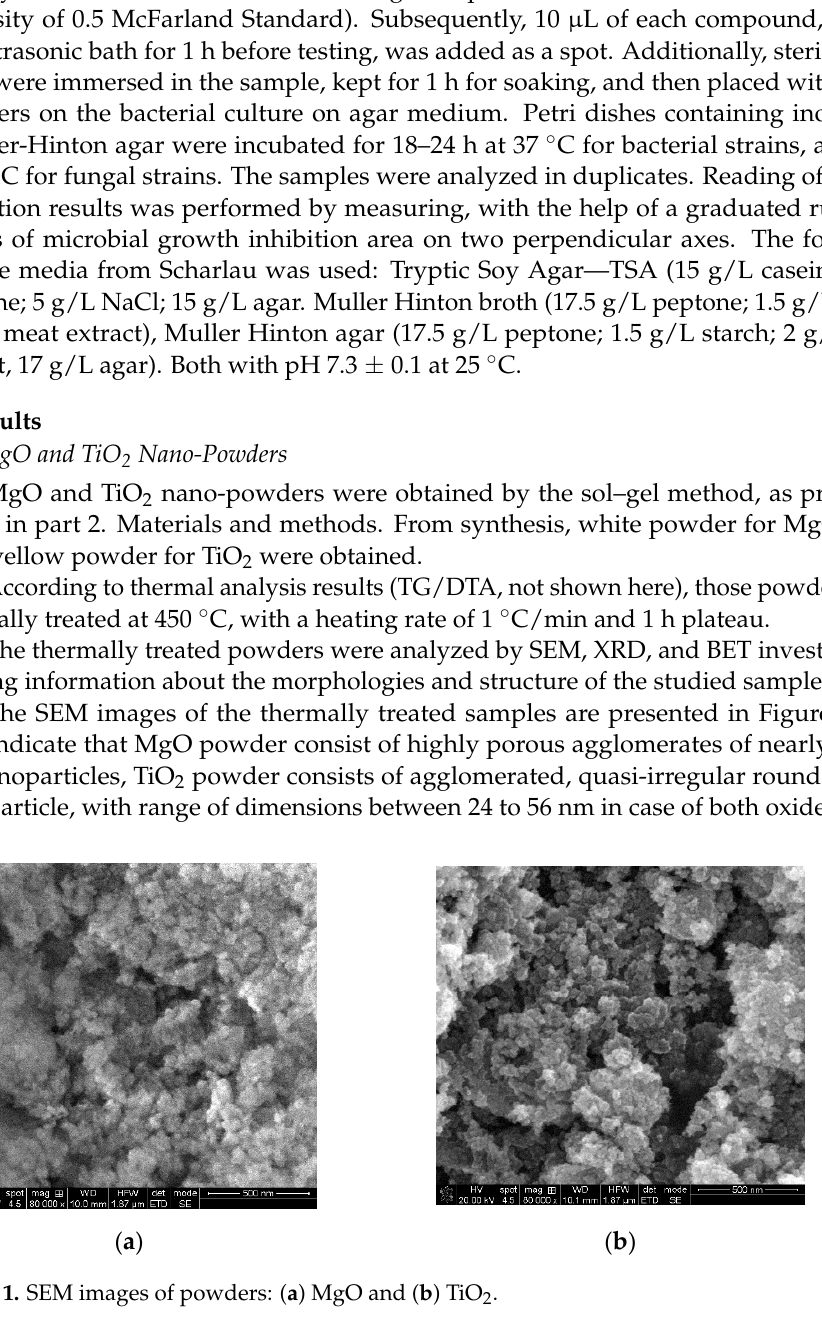
MgO and TiO 2 samples are pure phase, consisting of periclase (JCPDS card no. 045-0946) and anatase (JCPDS card no. 21-1272) phase, respectively. The nanocrystalline cubic peri- clase phase was confirmed by 2 θ = 36.87, 42.85, 62.25, 74.63, 78.56 corresponding to (111), (200), (220), (311), (222) reflections, in concordance with the reported data above, the lattice parameters are a = b = c = 4.2172 Ǻ , α = β = γ = 90°, and the crystallite size 158.7 Ǻ according to Williamson-Hall method. The nanocrystalline anatase phase was confirmed by 2 θ = 25.25, 37.8, 47.96, 53.93, 54.99, 62.86, 68.66, 70.25, 75.16, 82.78, corresponding to (101), (004), (200), (105), (211), (204), (116), (220), (215), (224) reflections and the lattice parameters are a = b = 3.7889 Ǻ , c = 9.4984 Ǻ , α = β = γ = 90 ٥ , and the crystallite size 104 Ǻ according to Williamson-Hall method. ( a ) ( b ) Figure 2. SEM images of powders: ( a ) MgO and ( b ) TiO2. The BET surface area analysis results are presented in Table 1. Although the samples have comparable surface area, MgO nano-powders are significantly more porous. Table 1. TiO 2 and MgO powders surface properties determined from BET measurements. Powder Sample BET Surface Area (m 2 /g) Total Pore Volume (cm 2 /g)